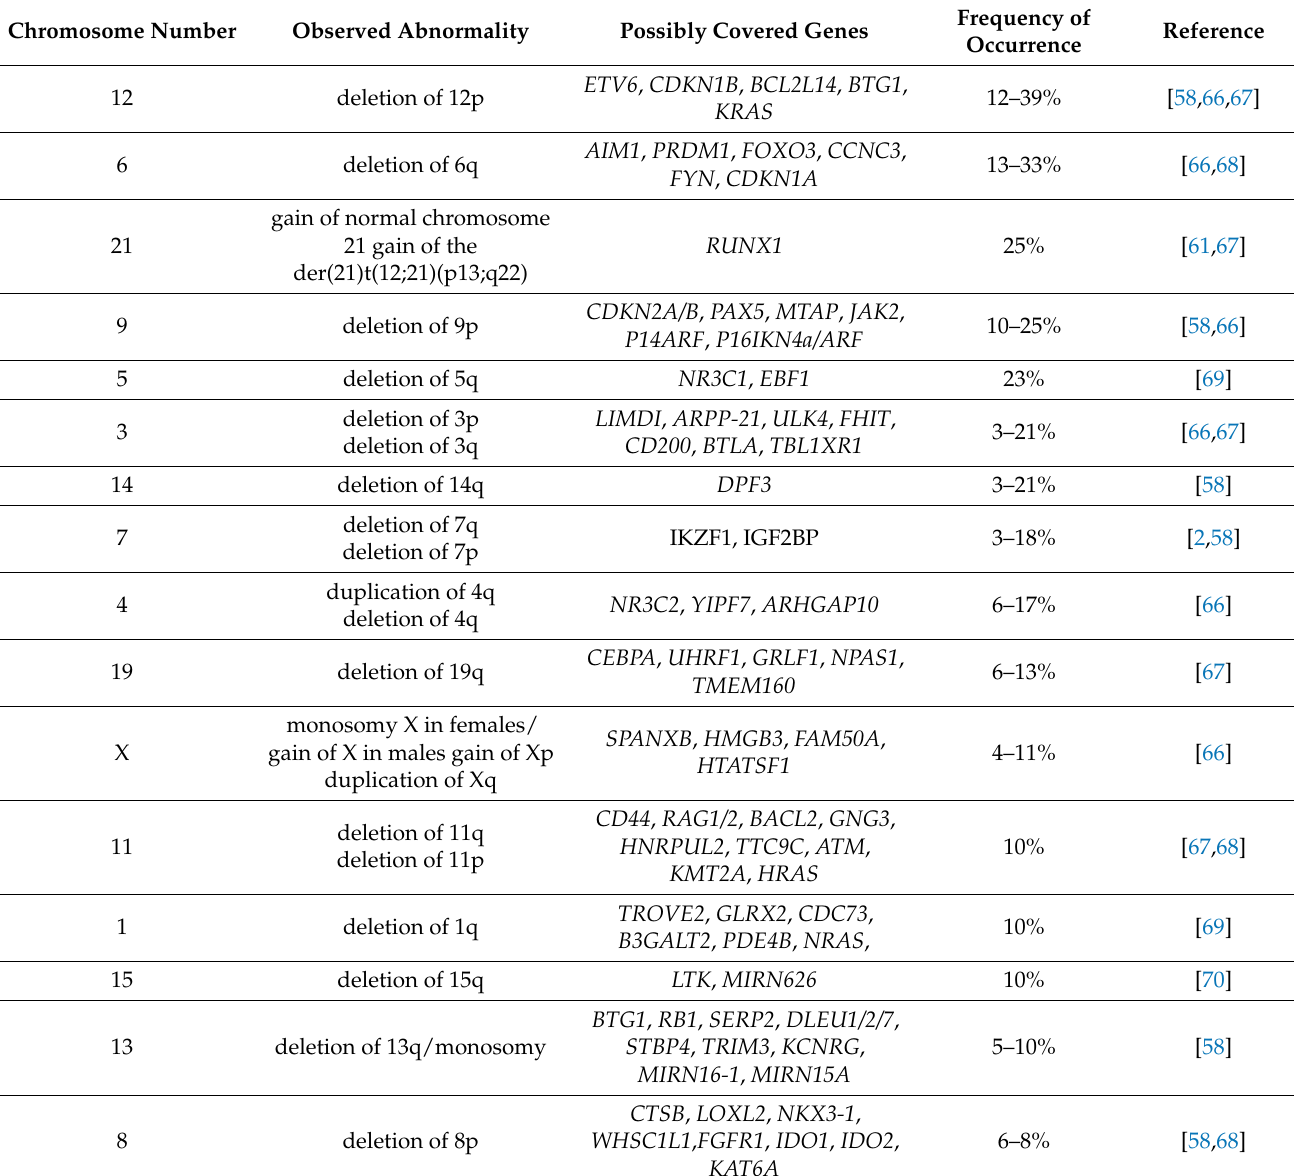
Table 1. Recurrent secondary genetic changes found in childhood ETV6::RUNX1